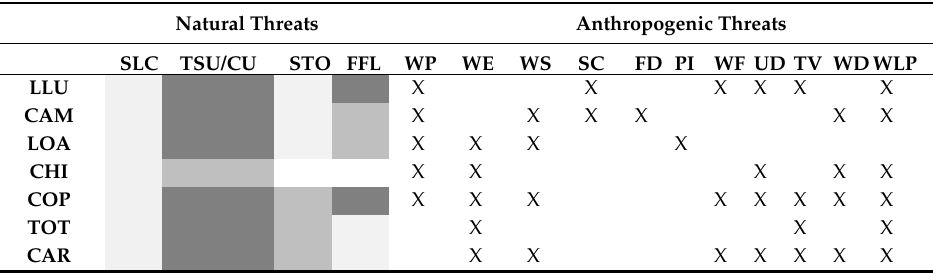
Table 2. Main natural and human threats to the arid coastal wetlands of northern Chile. Abbreviations of the wetland names are explained in Figure 3. Threats: SCL, sea-level change; TSU/CU, tsunami and coastal uplift; STO, storms; FFL, flash flood; WP, water pollution; WE; water extraction (surface and groundwater); WS, watershed (dammed); SC, soil contamination; FD, farming; PI, polluting industry; WF, wildfire; UD, urban development; TV, traffic of vehicles; WD, waste dump; WLP, wildlife perturbation and poaching; IS, invasive species. Dark, medium, and light gray colors indicate the different hazard grades, from high to low